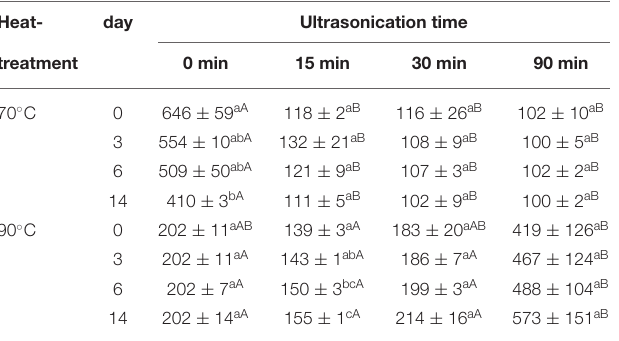
TABLE 2 | Size (nm) of PC: λ C (1:4) complexes was determined by DLS.